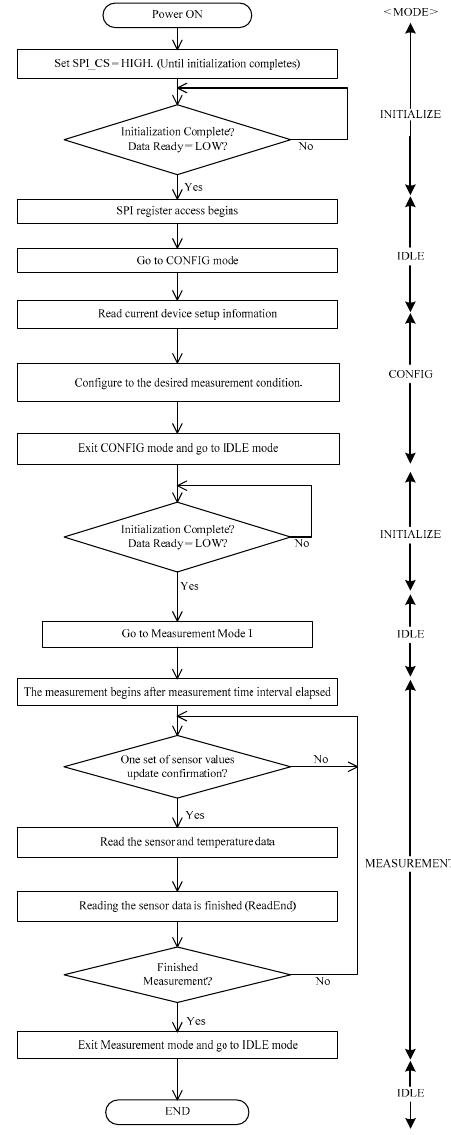
Figure 7. Flowchart of driver of M-A351AS [27].